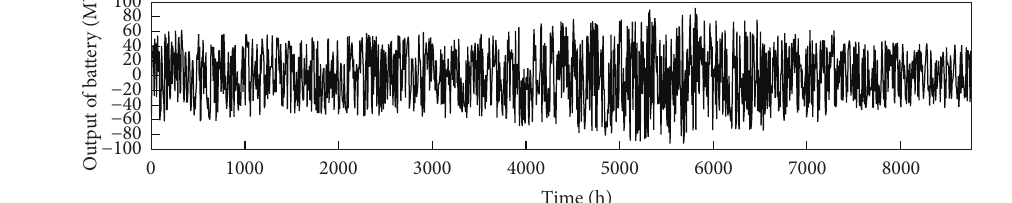
Figure 9: Output power curve of the battery.